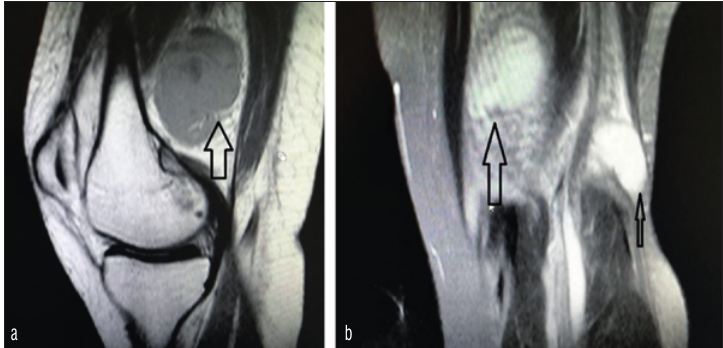
Figure 2. Magnetic resonance imaging of knee and popliteal fossa tumor recurrence: a) T1W sagittal view of the knee showing T1 hypointense, well rounded, recurrent mass behind the distal femoral epiphysis and b) T2W SPIR coronal view of the knee showing two soft tissue recurrent masses with severe perifocal edema behind the distal femoral